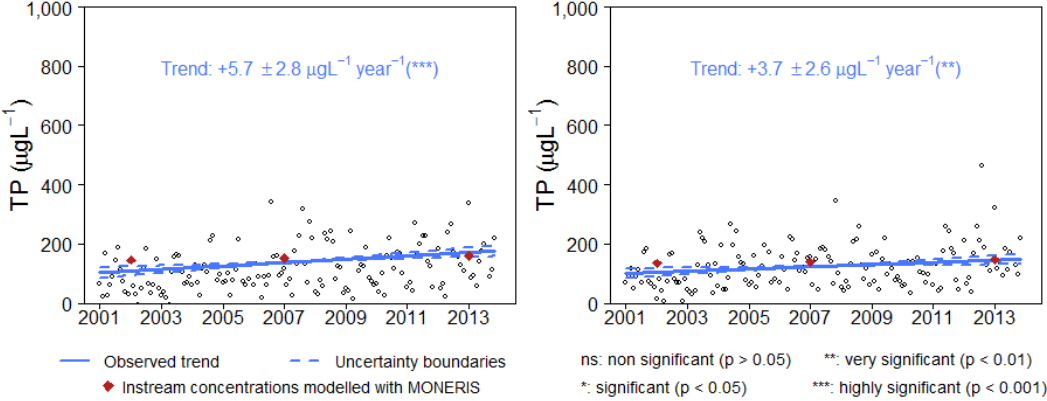
Figure 4. Observed trends of TP concentration compared to modelled TP concentrations for the years 2002, 2007 and 2013 in the two sub-catchments of the river Aschach: ( a ) upstream; and ( b ) downstream. Plotted values of TP concentrations correspond to flow-adjusted data. They were calculated by adding the residuals obtained from the concentration versus flow regression to the mean concentration for the period under study